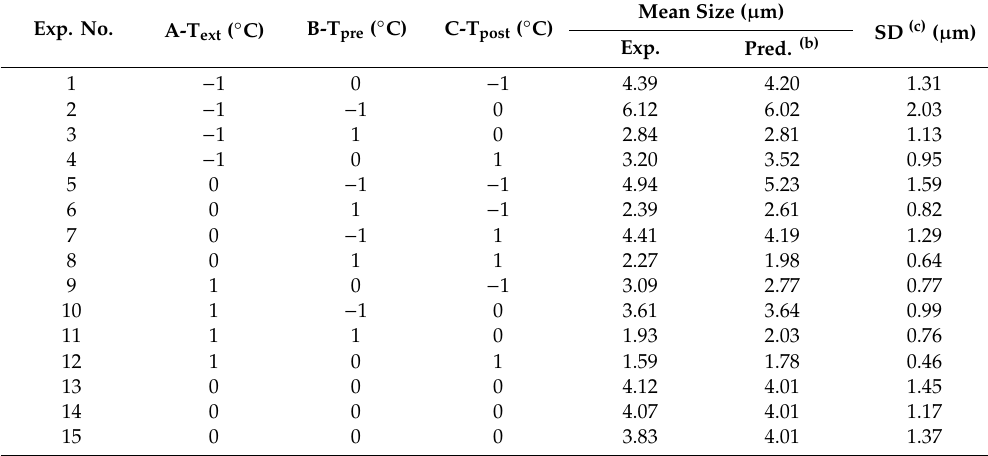
Table 2. Operating conditions and results of RESS Box–Behnken design (a) . Exp. No.